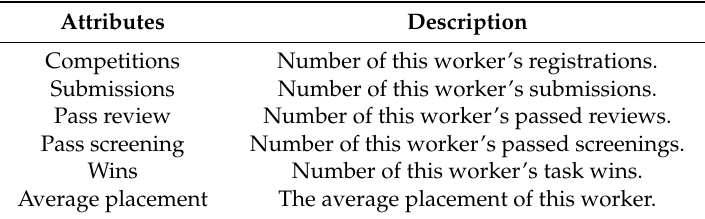
Table 4. The dataset of handler details’ attributes and